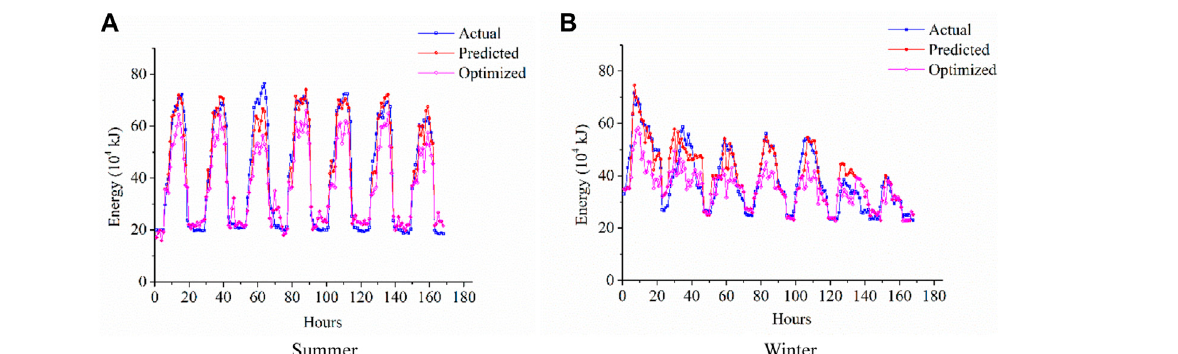
FIGURE 8 | Simulated energy consumption using the optimized controllable feature